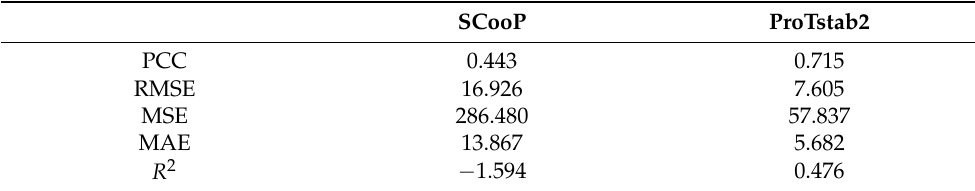
Table 6. Comparison of the performances of ScooP and ProTstab2 for the 438 proteins in the blind test set that SCooP was able to